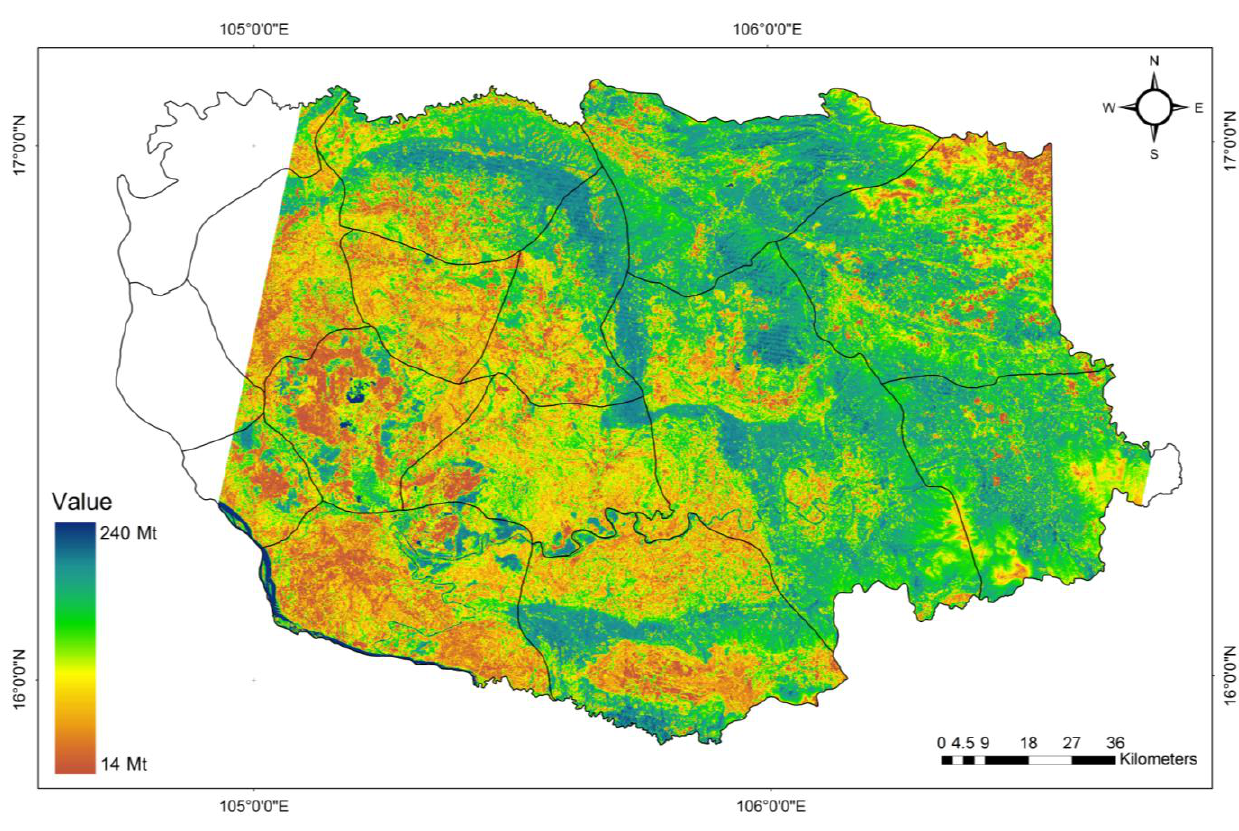
Figure 5. Carbon stock map of Savannakhet